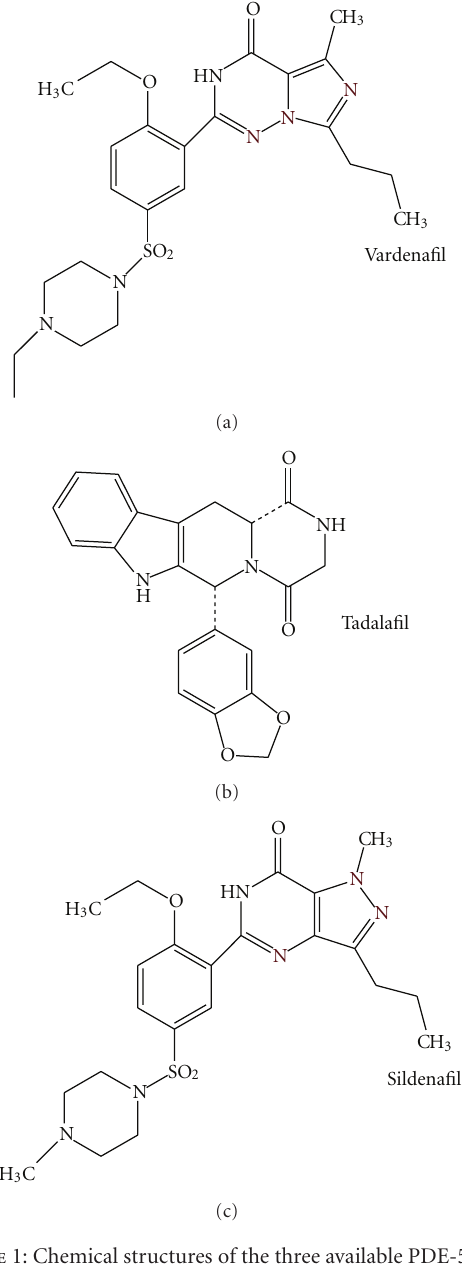
Figure 1: Chemical structures of the three available PDE-5Is [4].